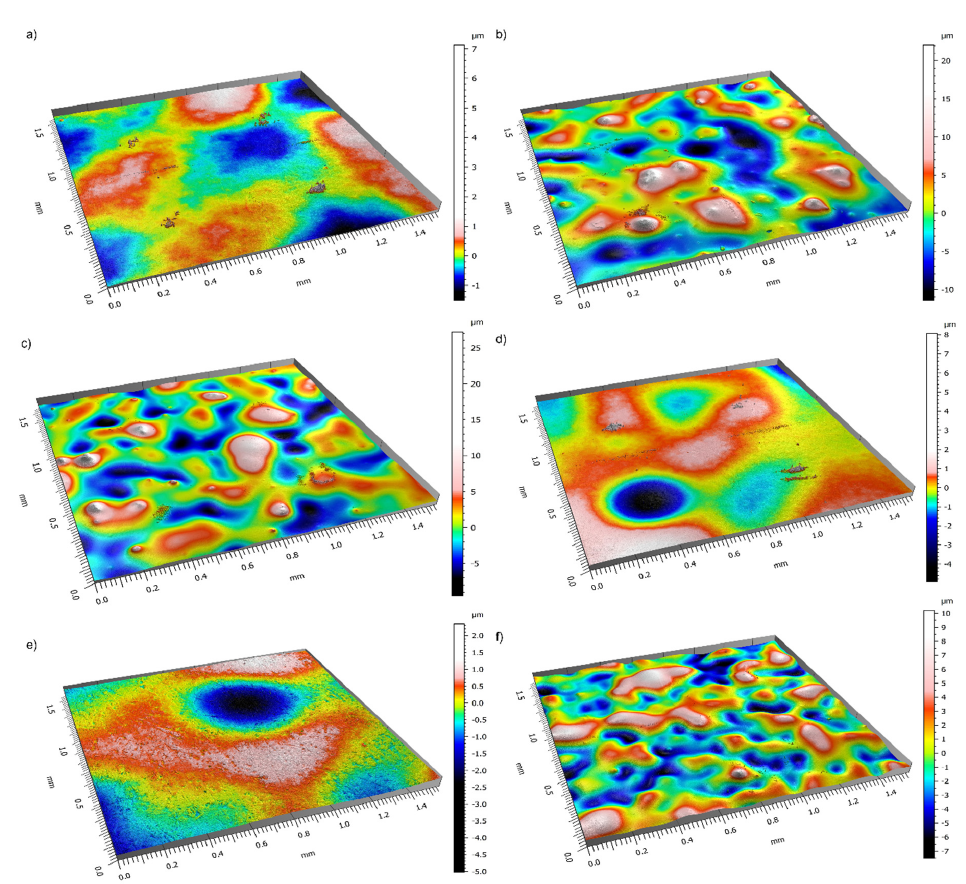
Figure 3. Profiles of the samples ( a ) Reference ( b ) SiO 2 + DC88 ( c ) SiO 2 ( d ) DC88 ( e ) POSS14 ( f ) SiO 2 + POSS14.